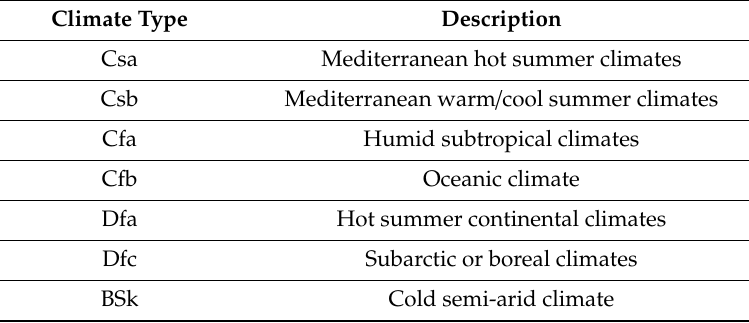
Table 3. Köppen–Geiger’s classification of climatic regions of